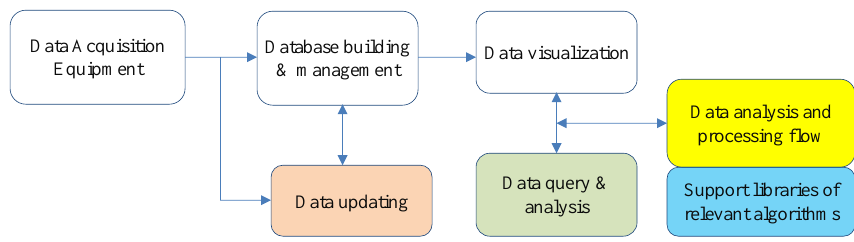
Figure 2. Data processing of a 3D geographic information system proposed in this